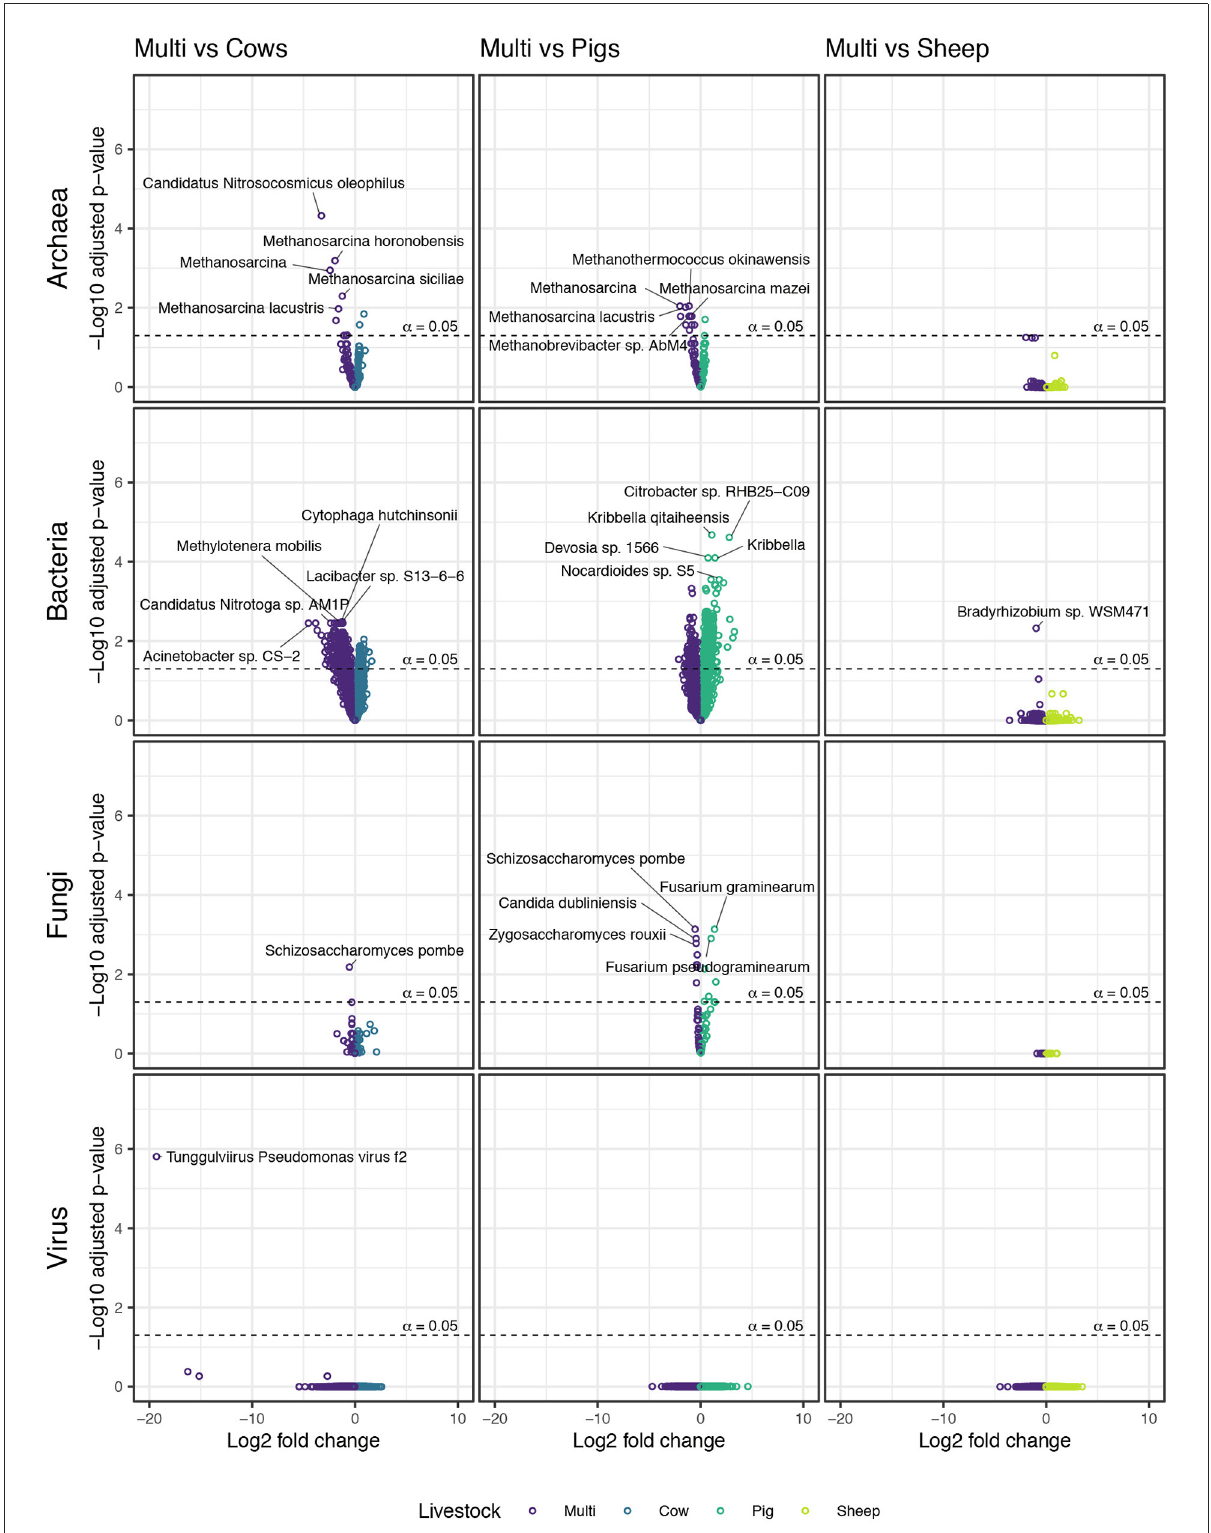
FIGURE7 Taxa from each microbial kingdom that were enriched in either monospecies or multi-species paddocks.